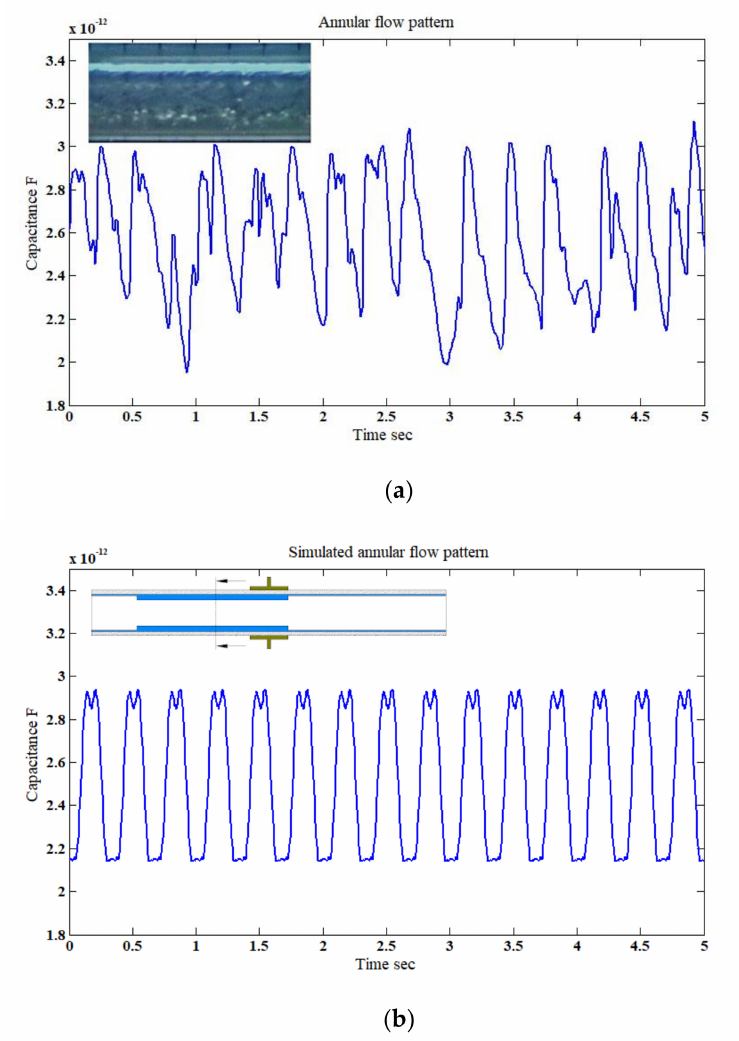
Figure 13. The time-dependent fluctuation of the capacitance value for an annular flow pattern: ( a ) experimental [32], and ( b ) simulation (for the superficial gas–liquid phase velocities of 5 m / s and 1.06 m / s, respectively; inclination angle β = 30 ◦